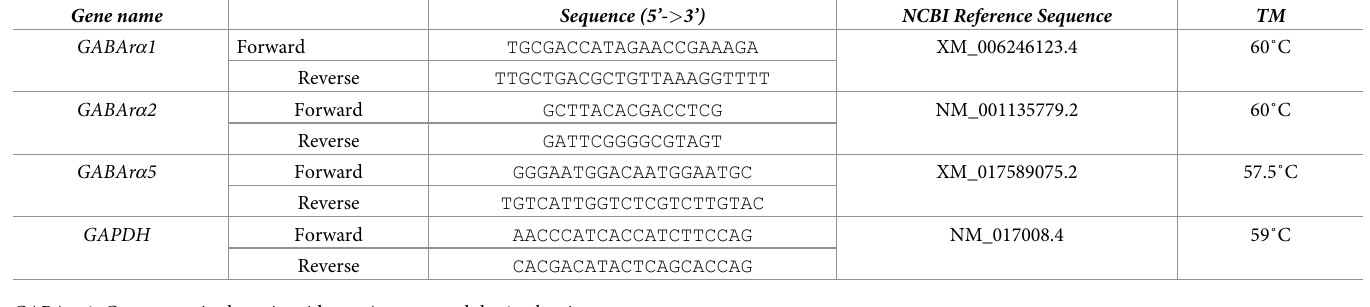
Table 1. Sequences of primers used in